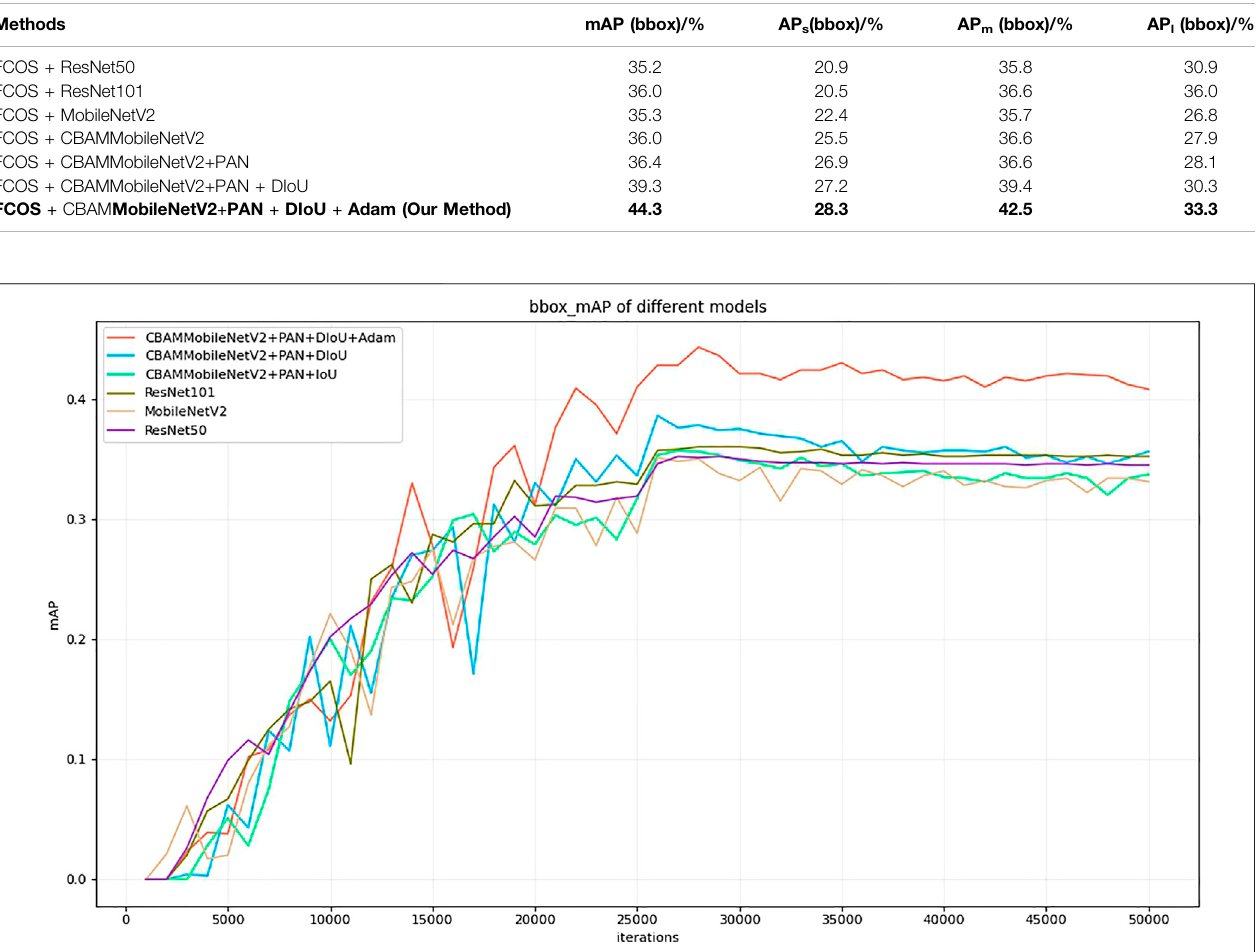
TABLE 3 | Defect detection results of different methods based on FCOS model.